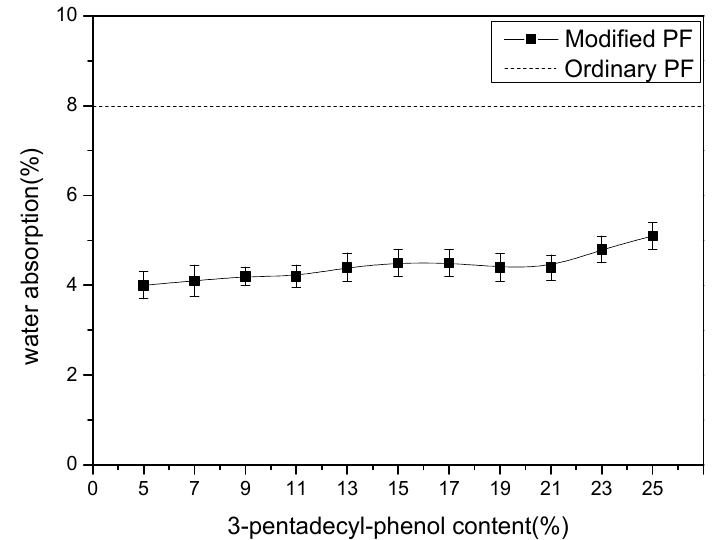
Figure 10. The effect of 3-pentadecyl-phenol with different contents on the water absorption rate of the foam.